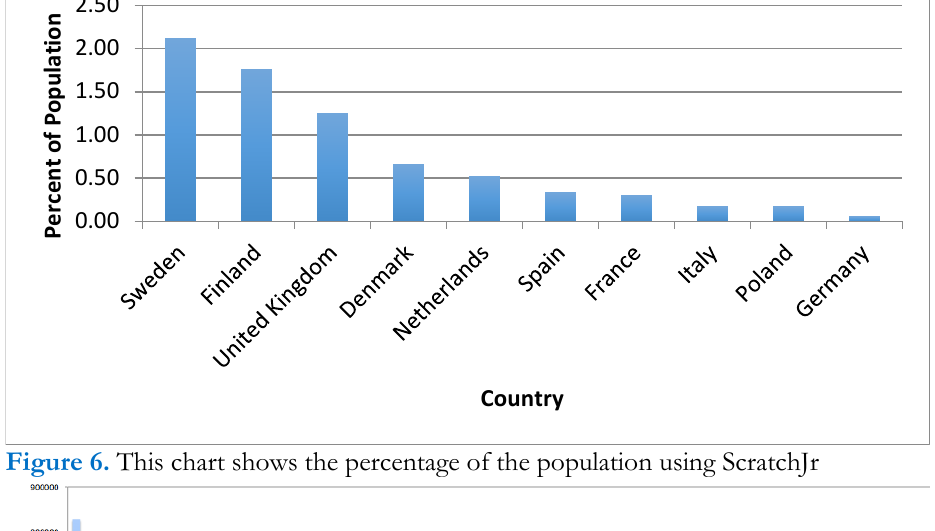
Figure 6. This chart shows the percentage of the population using ScratchJr